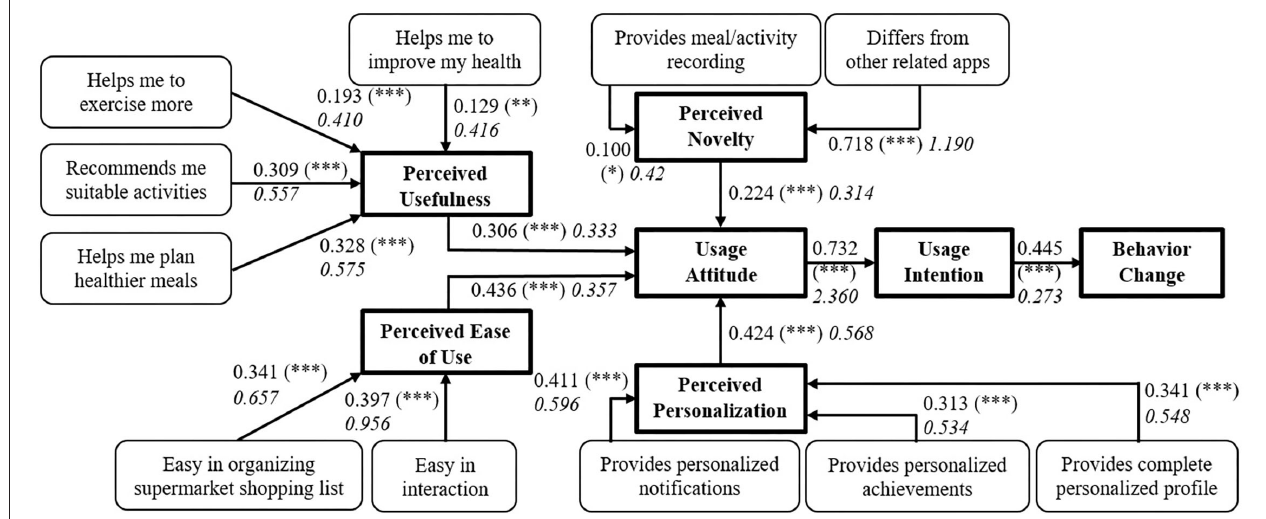
FIGURE 3 | Path relationships between mTAM main constructs ( Figure 2 ) and related items via the values of adj R 2 and the estimated regression coefficients (in italics). * p < 0.05; ** p < 0.01; *** p <